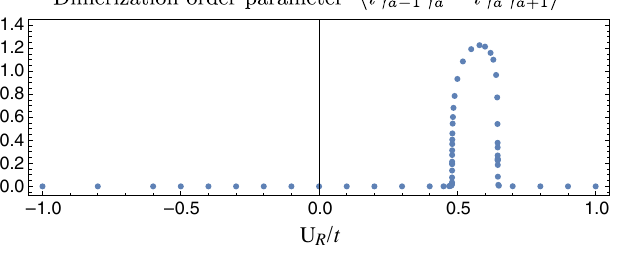
γ − i γ γ FIG. 16. Dimerization order parameter h i γ a − 1 a a a þ 1 i =t obtained from DMRG simulations of the Hamil- versus U R tonian in Eq. (B11). This Hamiltonian is the same as Eq. (B1) but with the interaction-induced kinetic energy renormalization subtracted off. The subtraction reduces the critical interaction strength required for spontaneous dimerization by 3 orders of =t ≈ 250 down to U =t ≈ 0 . 48 . Outside of magnitude — from U R R the dome-shaped dimerized region, the system realizes a gapless =t window state with central charge c ¼ 1 = 2 (at least over the U R =t ≳ 0 . 65 shown). Reentrance of the c ¼ 1 = 2 critical state at U R can also be understood from the subtraction, as we explain